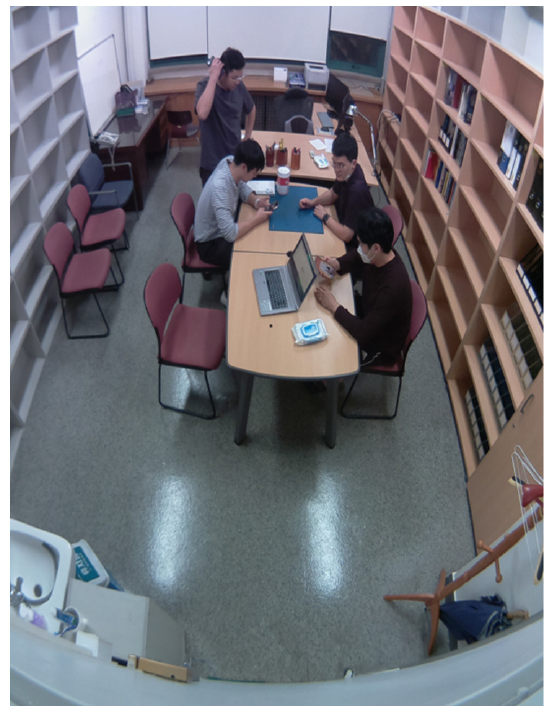
Figure 10. Original image data.